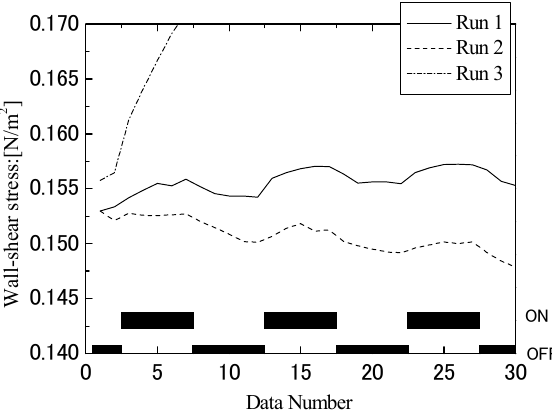
Fig.9 Wall-shear stress by PSJA on/off x D